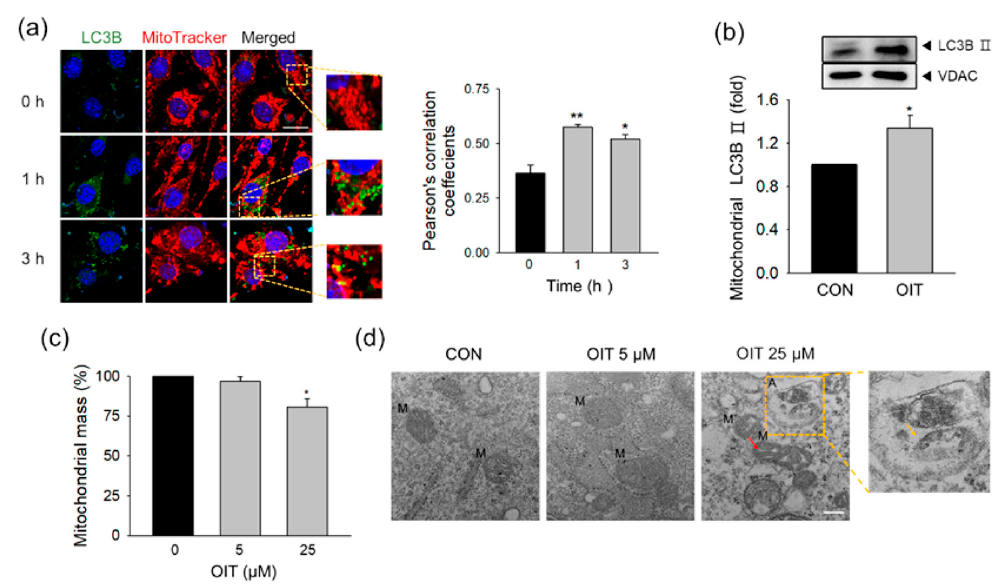
Figure 4. OIT-induced changes in mitophagy, mitochondrial mass, and mitochondrial morphology in bEND.3 cells. ( a ) The localization of LC3B (autophagosome) and MitoTracker (mitochondria) was examined 0, 1, and 3 h after treatment with 25 μ M OIT by confocal microscopy. Scale bar: 20 μ m. Pearson’s correlation coefficient was calculated from three independent experiments using ImageJ software ( n = 3). ( b ) LC3B-II protein levels were detected in the mitochondrial fraction 3 h after treatment with 25 μ M OIT ( n = 3). ( c ) Mitochondrial mass was examined 3 h after treatment with OIT by nonyl acridine orange (NAO) staining ( n = 3). ( d ) Changes in mitochondrial morphology and autophagosome formation were detected 3 h after treatment with 5 and 25 μ M OIT by TEM ( n = 3). M, mitochondria; A, autophagosome; red arrow, swollen mitochondria with distorted cristae; yellow box and yellow arrow, mitochondria-contained vesicle. Scale bar: 200 nm. Data are presented as mean ± SEM. * p < 0.05, ** p < 0.01 vs. CON (control).